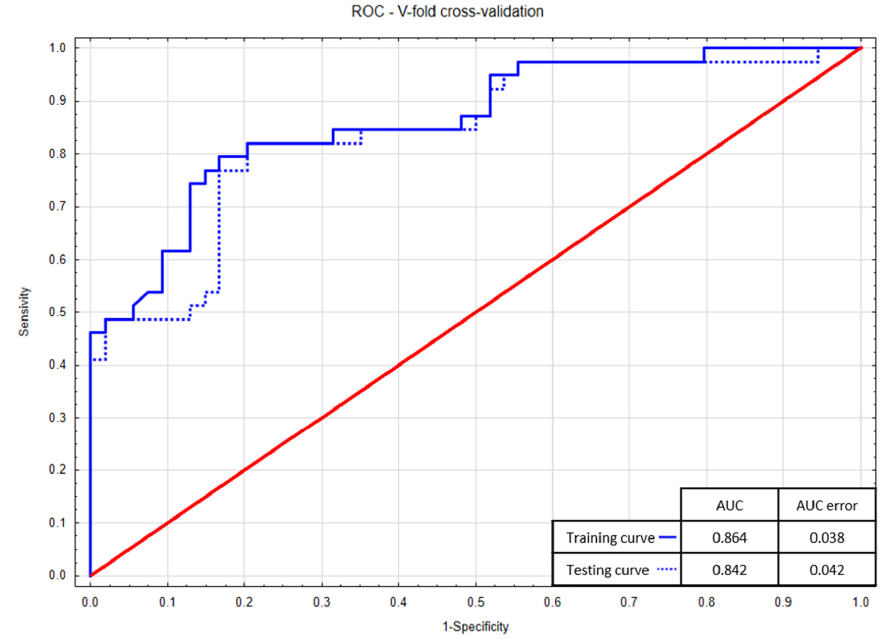
Figure 3. V-fold cross-validation—learning ROC curves for the logistic regression model including brushing frequency per day.